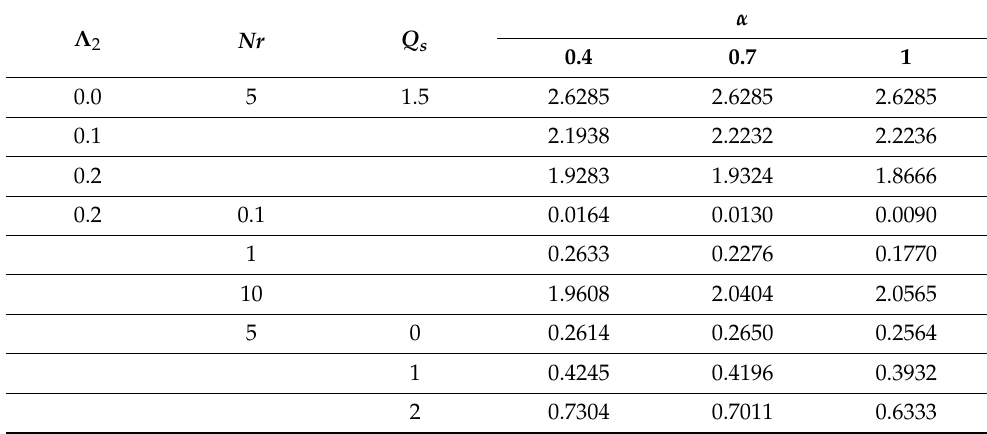
Table 3. Variation in the local Nusselt number as varying the physical parameters and α